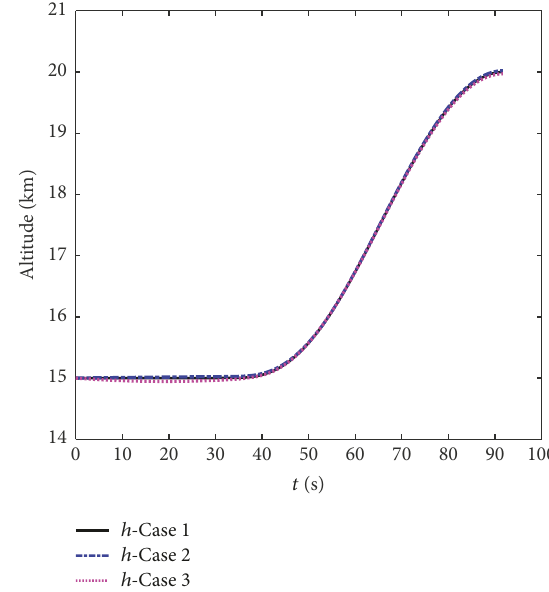
Figure 7: Variation of the altitude.